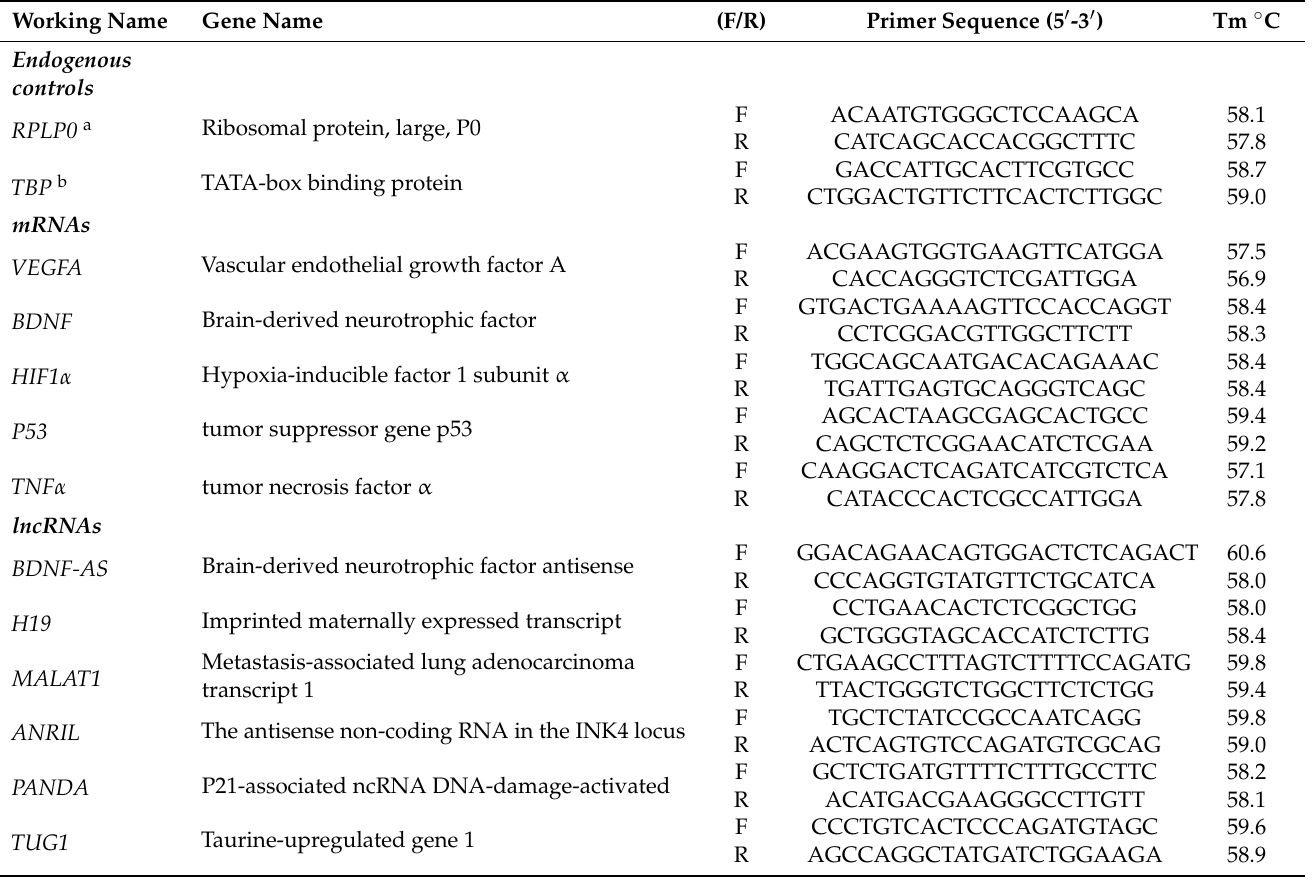
Table 2. Primer sequences of endogenous controls, mRNAs, and lncRNAs used for qPCR and